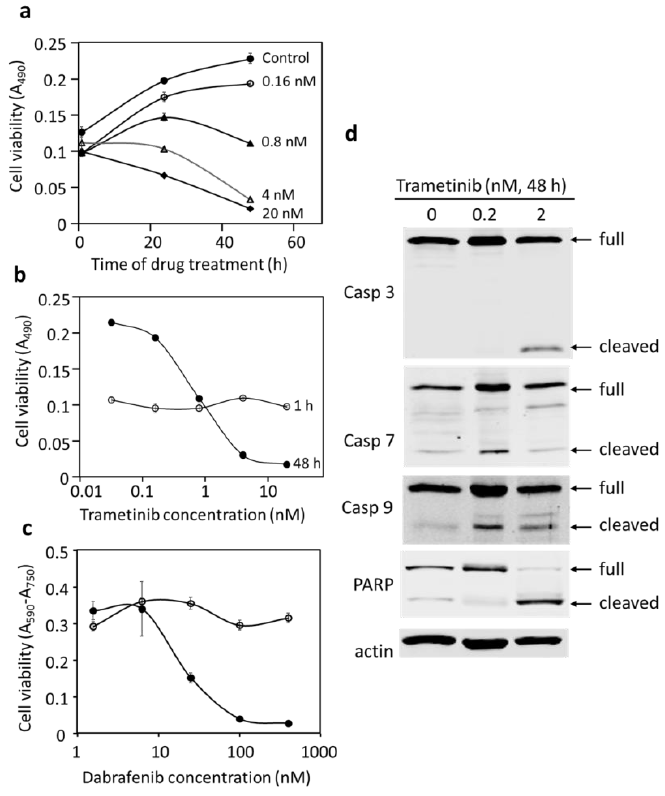
Figure 3. Effects of trametinib and dabrafenib on DU-4475 cell viability and death. ( a ) Growth curves of DU-4475 treated with different concentrations of trametinib over time. ( b ) Dose – response curves